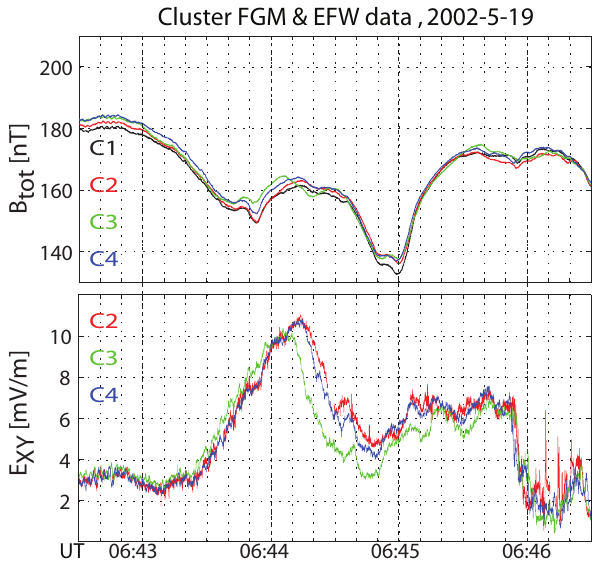
Fig. 6. Multi-spacecraft overplot of DC total magnetic field (up- per panel) and total spin-place electric field (lower panel) during 06:42:30 ∼ 06:46:30UT, 19 May 2002 observed by FGM and EFW. Both the magnetic field and the spin axis point nearly northward during this period. Data are de-spined (spin period is about 4s) af- ter sampled at 25Hz for the electric field (EFW) and 22.4Hz for the magnetic field (FGM). SC-1 electric field data is not shown because of de-spin problem. The highest peak of the SC-1 electric field ap- pears at about 06:44:15UT at nearly the same timing as SC-2 and SC-4 although the SC-1 data is not shown